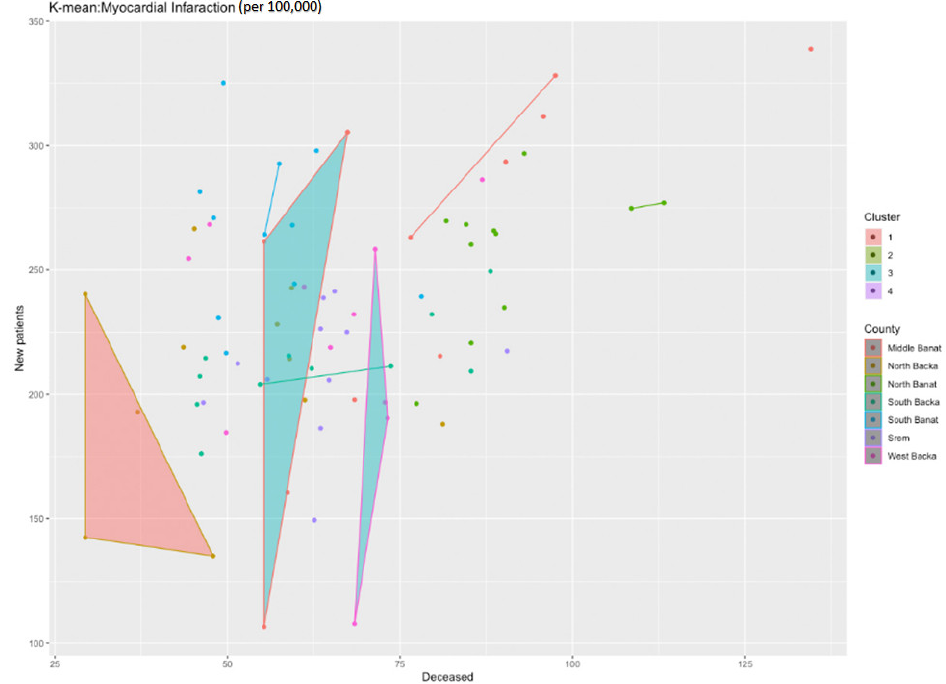
Figure 8. Identification of clusters in the course of analyzing myocardial infarction in the researched area.